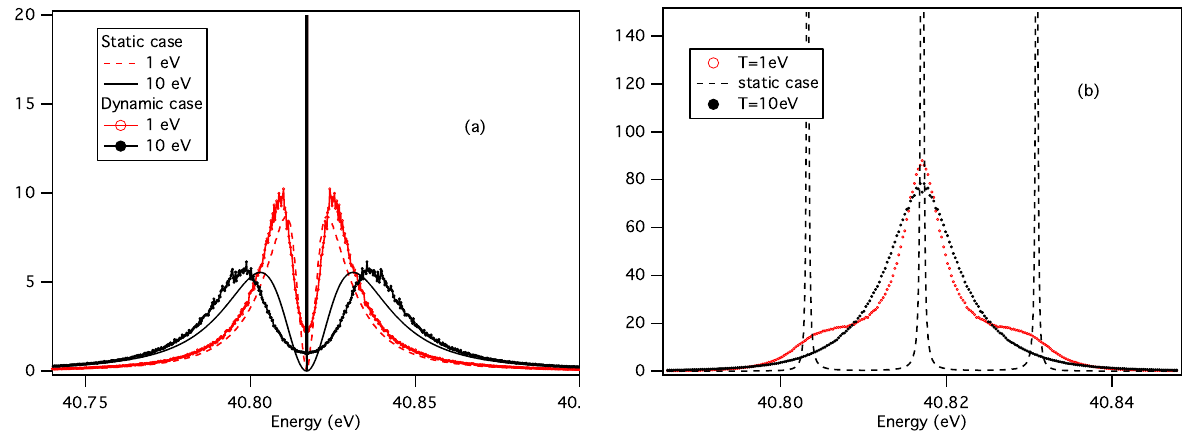
Figure 3. Spectral line shapes of the Lyman- α line in a pure vibrating field ( a ) and a pure rotating field ( b ) compared to the corresponding static profiles, at n = 10 19 cm − 3 and two temperatures, T = 1 and T = 10 eV. The dynamic case results have been obtained with the BinGo simulation